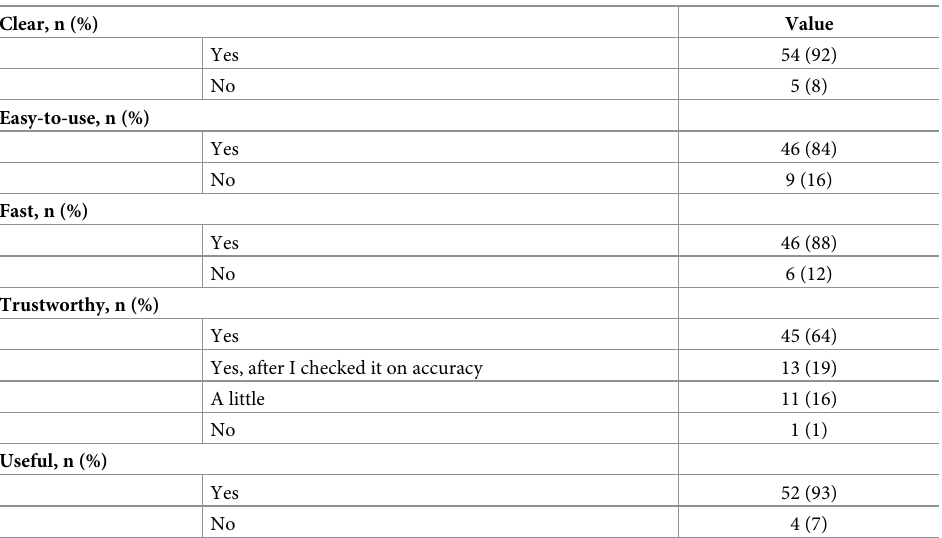
Table 4. Impressions of the COVID-19 app by questionnaire respondents (N = 70). Clear, n